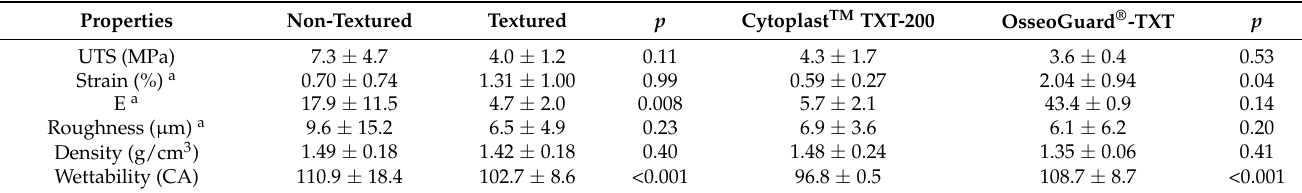
a Statistical comparison performed with values on a log scale. Abbreviations see Table